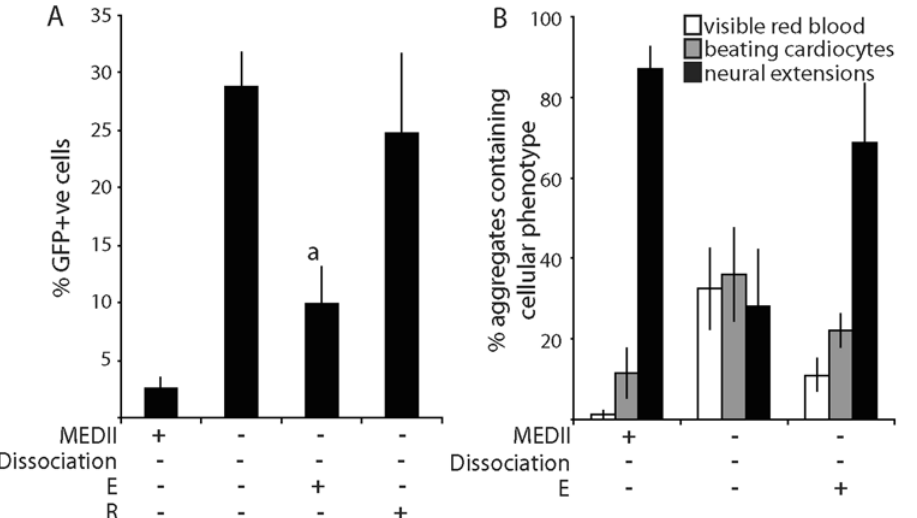
Figure 4. The MEDII-associated mesoderm suppressing activity is found within the small molecular weight components of the medium. ( A ). Mixl1:GFP ES cells were cultured as aggregates in MEDII for 3 days to form EPL cells. Aggregates were transferred to unsupplemented medium or medium supplemented with 50% MEDII, 50% E or R and cultured for a further 2 days before reduction to a single cell suspension. The proportion of GFP + cells present was determined by flow cytometry. n=7 independent experiments (MEDII 2 Dis 2 R + n=3). Error bars represent sem. (a) represents a decrease when compared with MEDII-Dis- where p , 0.001. ( B ). EPL cells were prepared as for (A) and transferred to unsupplemented medium or medium supplemented with 50% MEDII or 50% E. Aggregates were maintained in culture for a further 4 days before being seeded individually into 48 tissue culture wells and allowed to differentiate. Aggregates were scored for the presence of visible red blood cells, beating cardiocytes and neural extensions and the peak score for each represented. n=3 independent experiments and includes data generated from both Mixl1:GFP and D3 ES cell lines. Error bars represent sem.